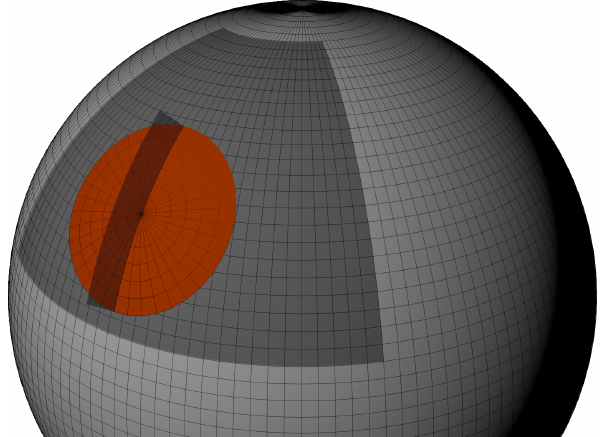
Figure 2. Schematic of the size of the analysed region (dark grey) in comparison to the full sphere, as well as the size of a rotated spheric polar coordinate system (orange) with (cid:50) max = 15 ◦ radius. The dark grey semi-transparent upright plane illustrates (with exag- gerated vertical extent) the vertical cross section aligned from north to south as displayed in Fig.